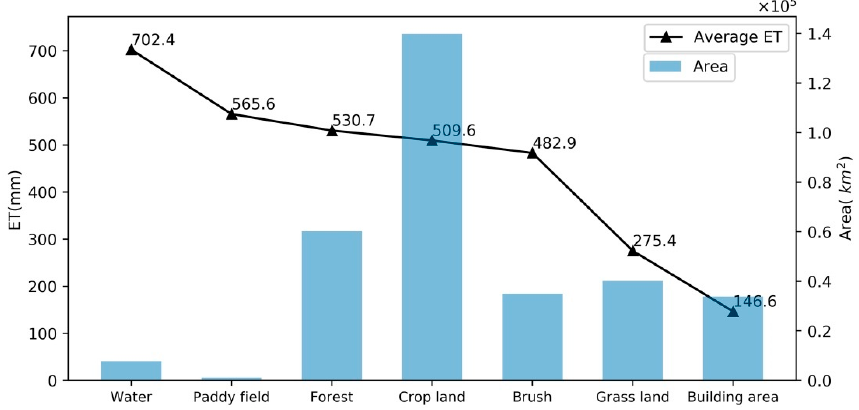
Figure 4. The area of land use and annual average ET in 2014 in the Hai Basin.